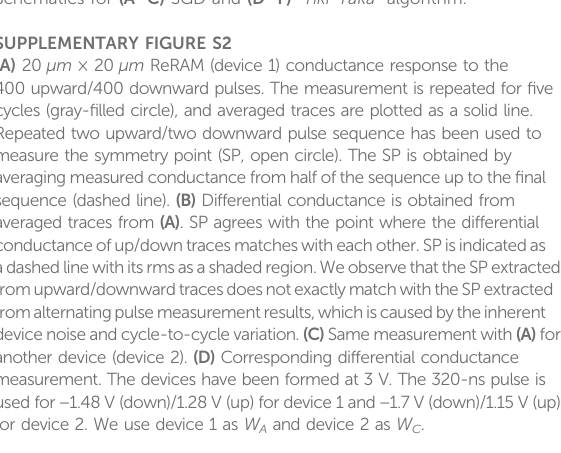
upward/downward pulse is clearly observed. (1,2) and (2,1) devices are half- selected, respectively. A random fl uctuation has been observed. The (2,2) device is unselected, and no fl uctuation has been observed. (B) Similar experiment is carried out but by selecting the (2,1) device. The device has been tested under fi ve super cycles of upward/downward pulse sequences, and the response is indicated as gray symbols. The averaged upward/downward pulse responses are indicated as blue/red solid lines,